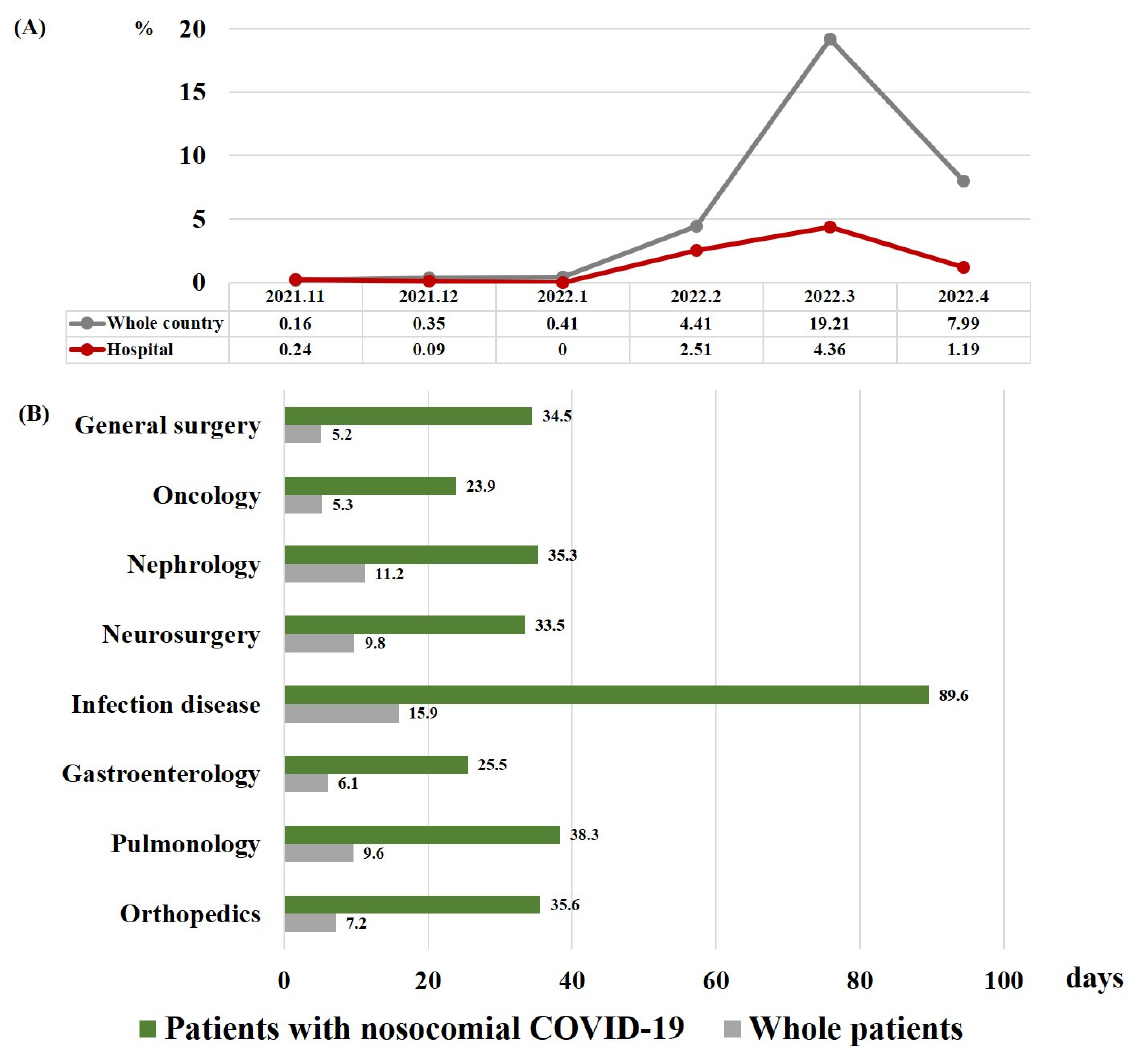
Figure 1. ( A ) Incidence of nosocomial COVID-19 in all hospitalized patients and of COVID-19 in the population of the country as a whole. ( B ) Median length of hospital stay for patients with nosocomial COVID-19 and for all patients in each department. Abbreviation: COVID-19, coronavirus disease 2019. Table 1. Clinical characteristics of patients with nosocomial COVID-19 (n = 167).